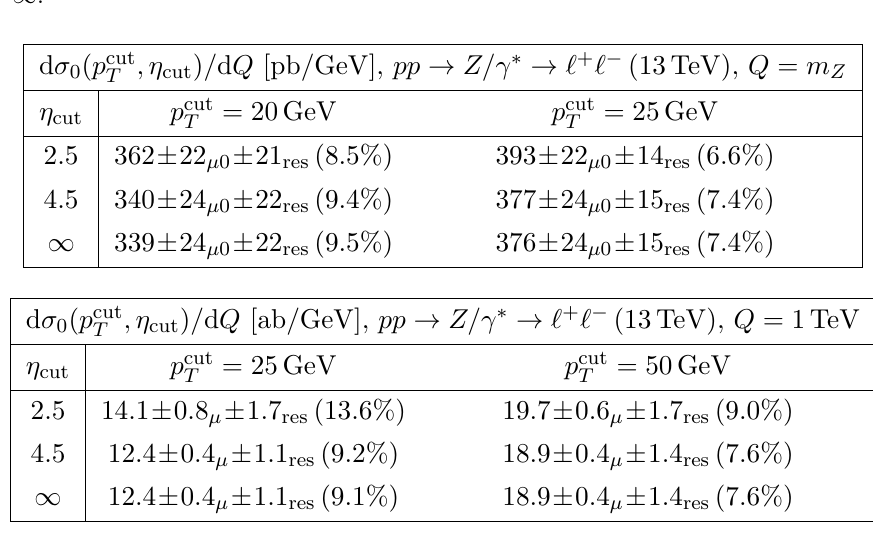
and (cid:17) cut with a breakdown of the T